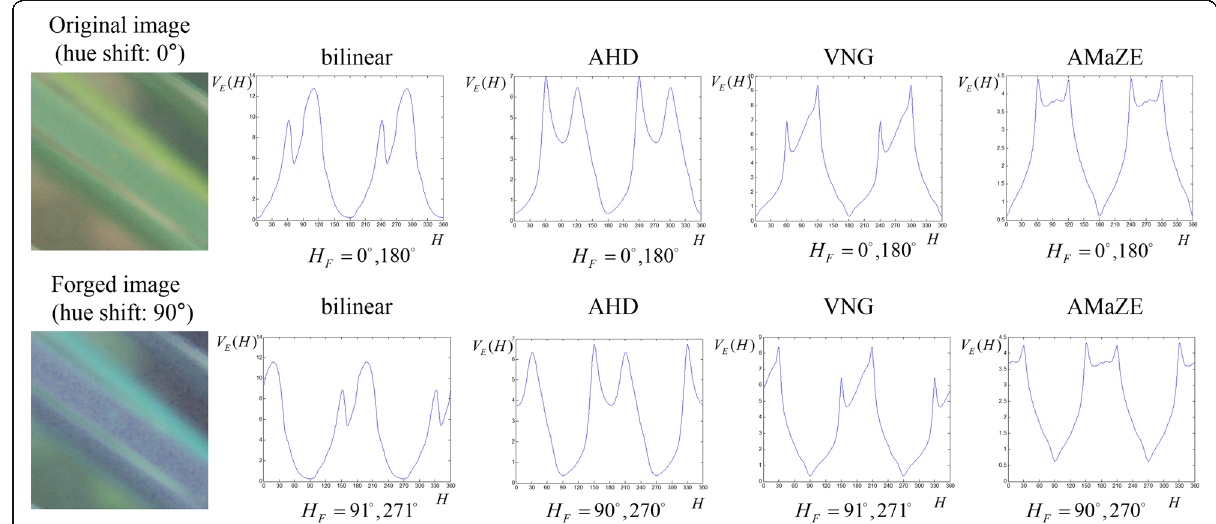
Fig. 4 Estimated shift angles obtained by the proposed algorithm for various demosaicing methods when angles are shifted by 0° and